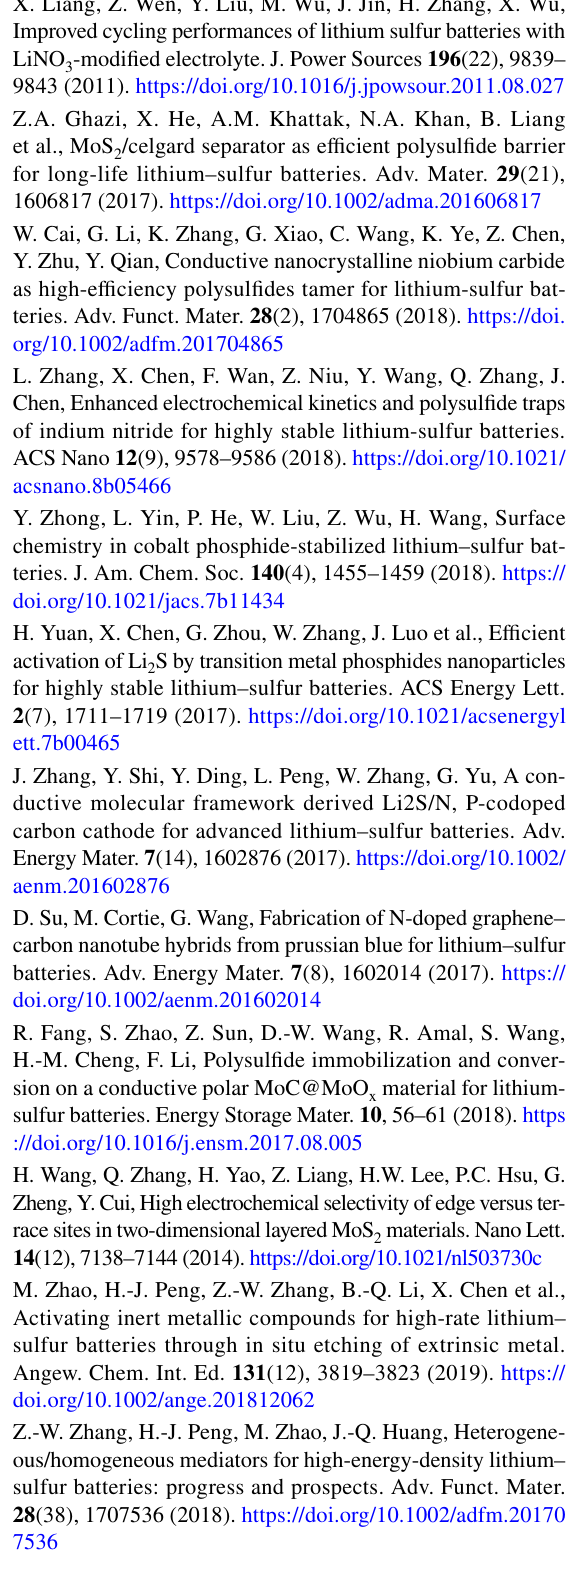
figuration of an integrated flexible sulfur cathode for high‑ performance lithium‑sulfur batteries. Angew. Chem.